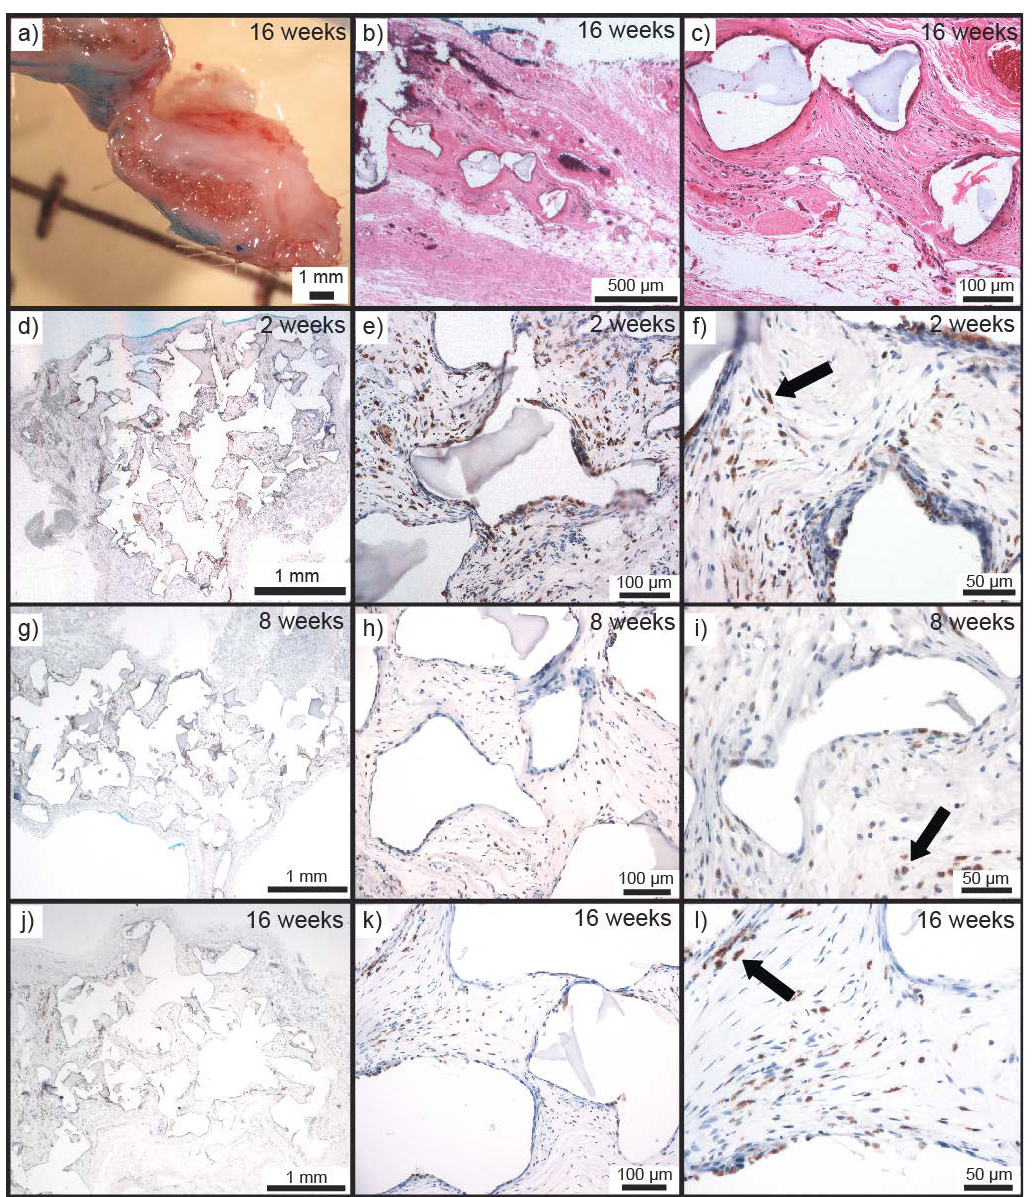
Figure 6. ( a ) Macroscopic cross-section of Seb-PEH 2 removed at 16 weeks. H&E stained section of